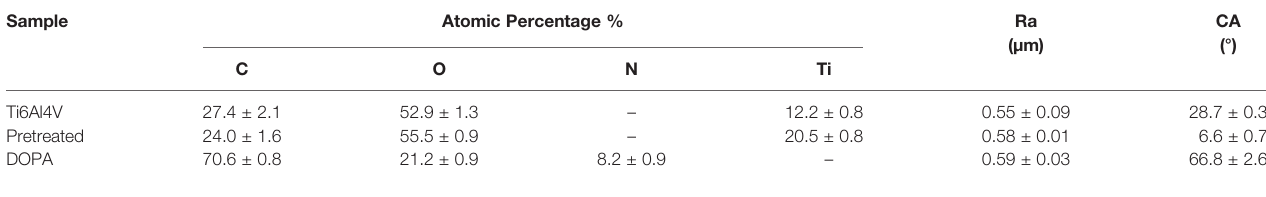
TABLE 3 | Average XPS atomic surface composition, surface roughness and contact angle values for crude Ti6Al4V, pretreated and DOPA grafted samples. Sample